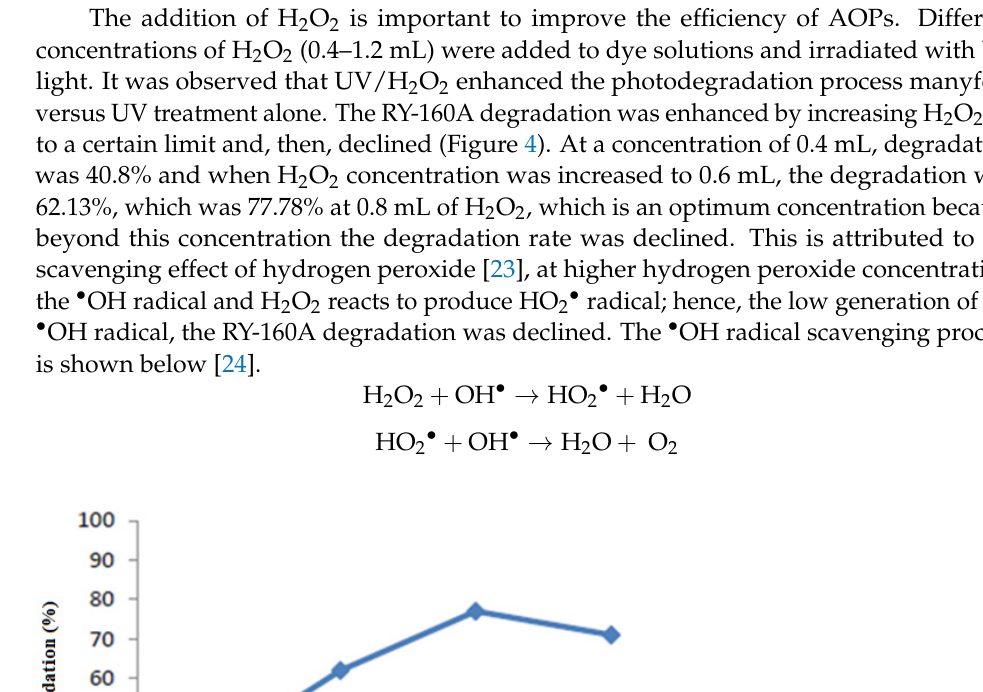
Figure 3. UV irradiation time on % degradation efficiency of Reactive Yellow 160A.